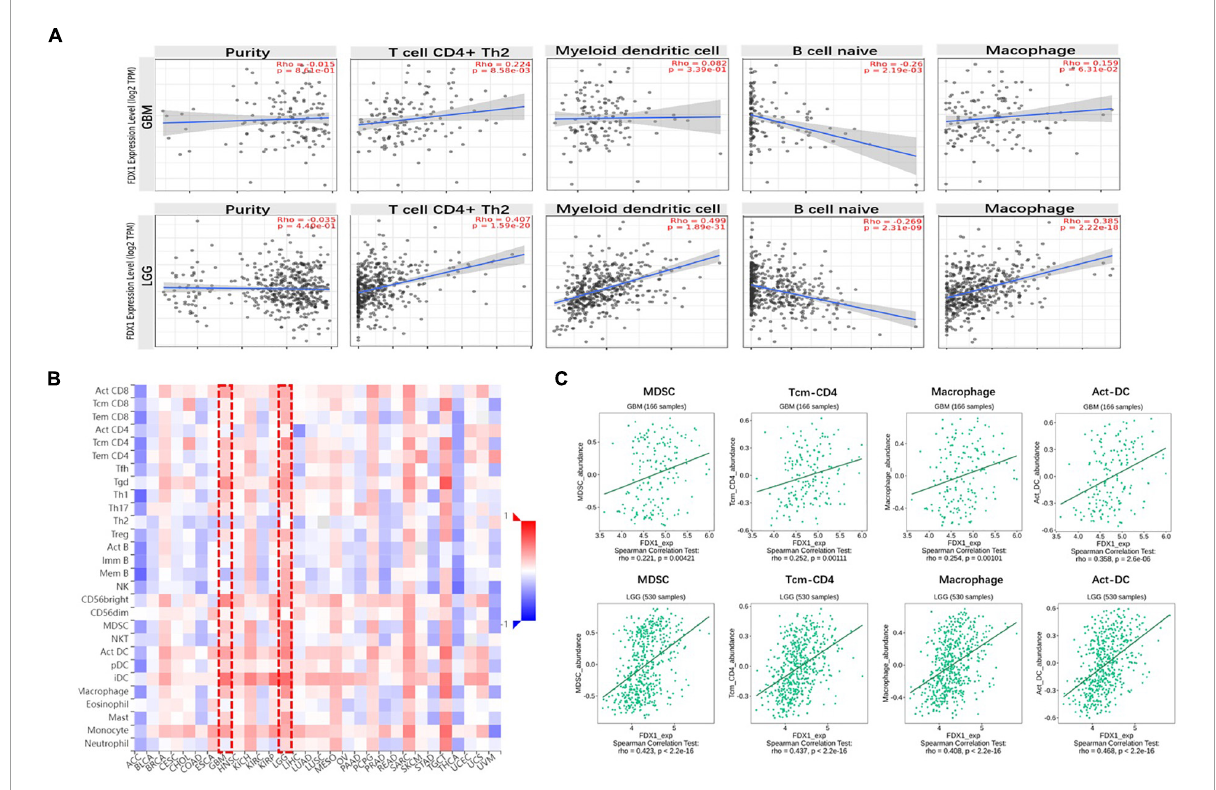
FIGURE7 The relationship between FDX1 gene expression and immune infiltration level in glioma. (A) Expression of FDX1 gene related to immune infiltration of CD4 + T cells, Dendritic cells, B cells and macrophage cells in glioma. (B) Analysis between FDX1 gene expression and immune infiltration levels by TISIDB. (C) Correlations between FDX1 gene expression and Dendritic cells, effector memory CD4 T cells, Myeloid-derived suppressor cells and macrophage cells infiltration in